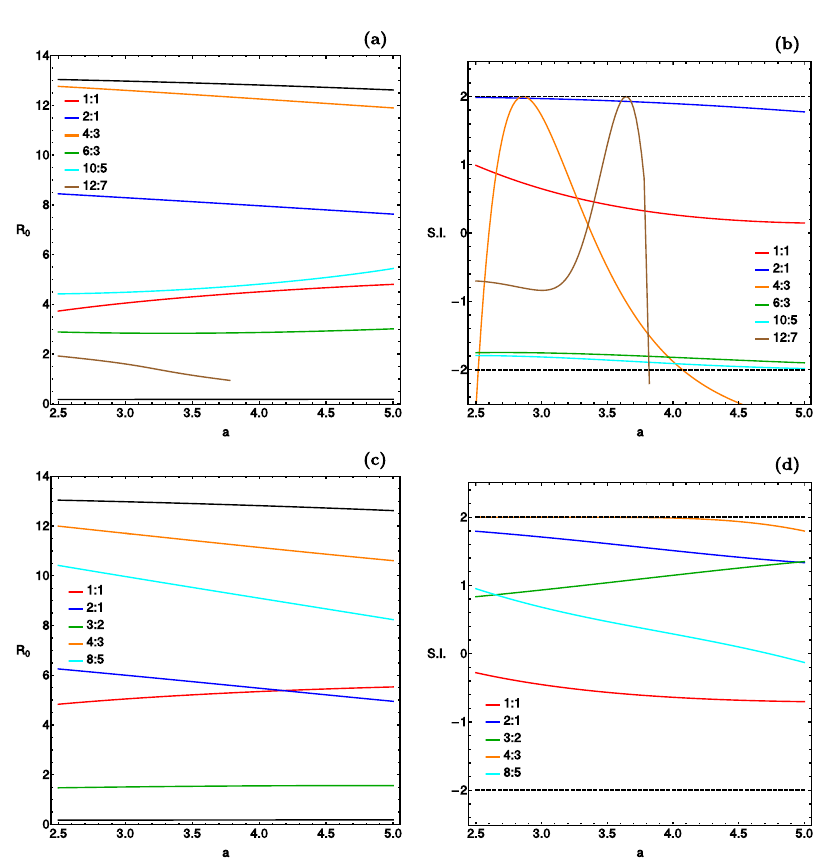
Fig. 5. Evolution of the R coordinate of periodic orbits as a function of the scale length of the disk, (cid:11) , for the PH models (panel a) and OH models (panel c), and the evolution of the stability index S.I. as a function of (cid:11) for the PH models (panel b) and OH models (panel d). evolution of the position of all resonant families of periodic orbits as a function of (cid:11) for the OH models is given in Fig. 5c. The corresponding stability diagram